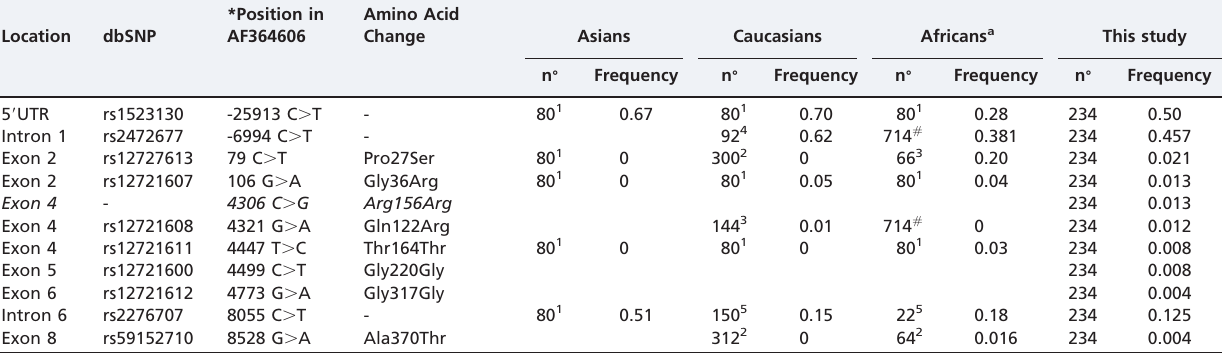
Table 1 - Allelic frequency of polymorphisms in the PXR gene in Brazilians compared to Asians, Caucasians, and Africans. Location dbSNP